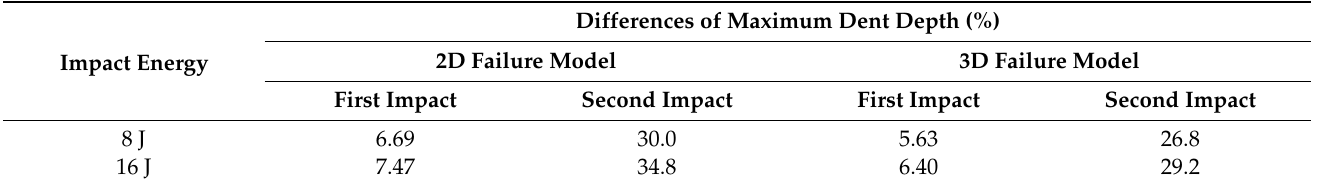
Table 8. Difference between the predicted and measured maximum dent depth for GLARE 5-2/1.